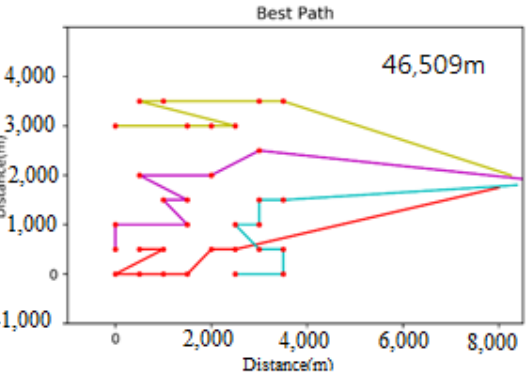
Figure 14. Optimal cable layout by restricting a maximum of 8 interconnecting turbines.